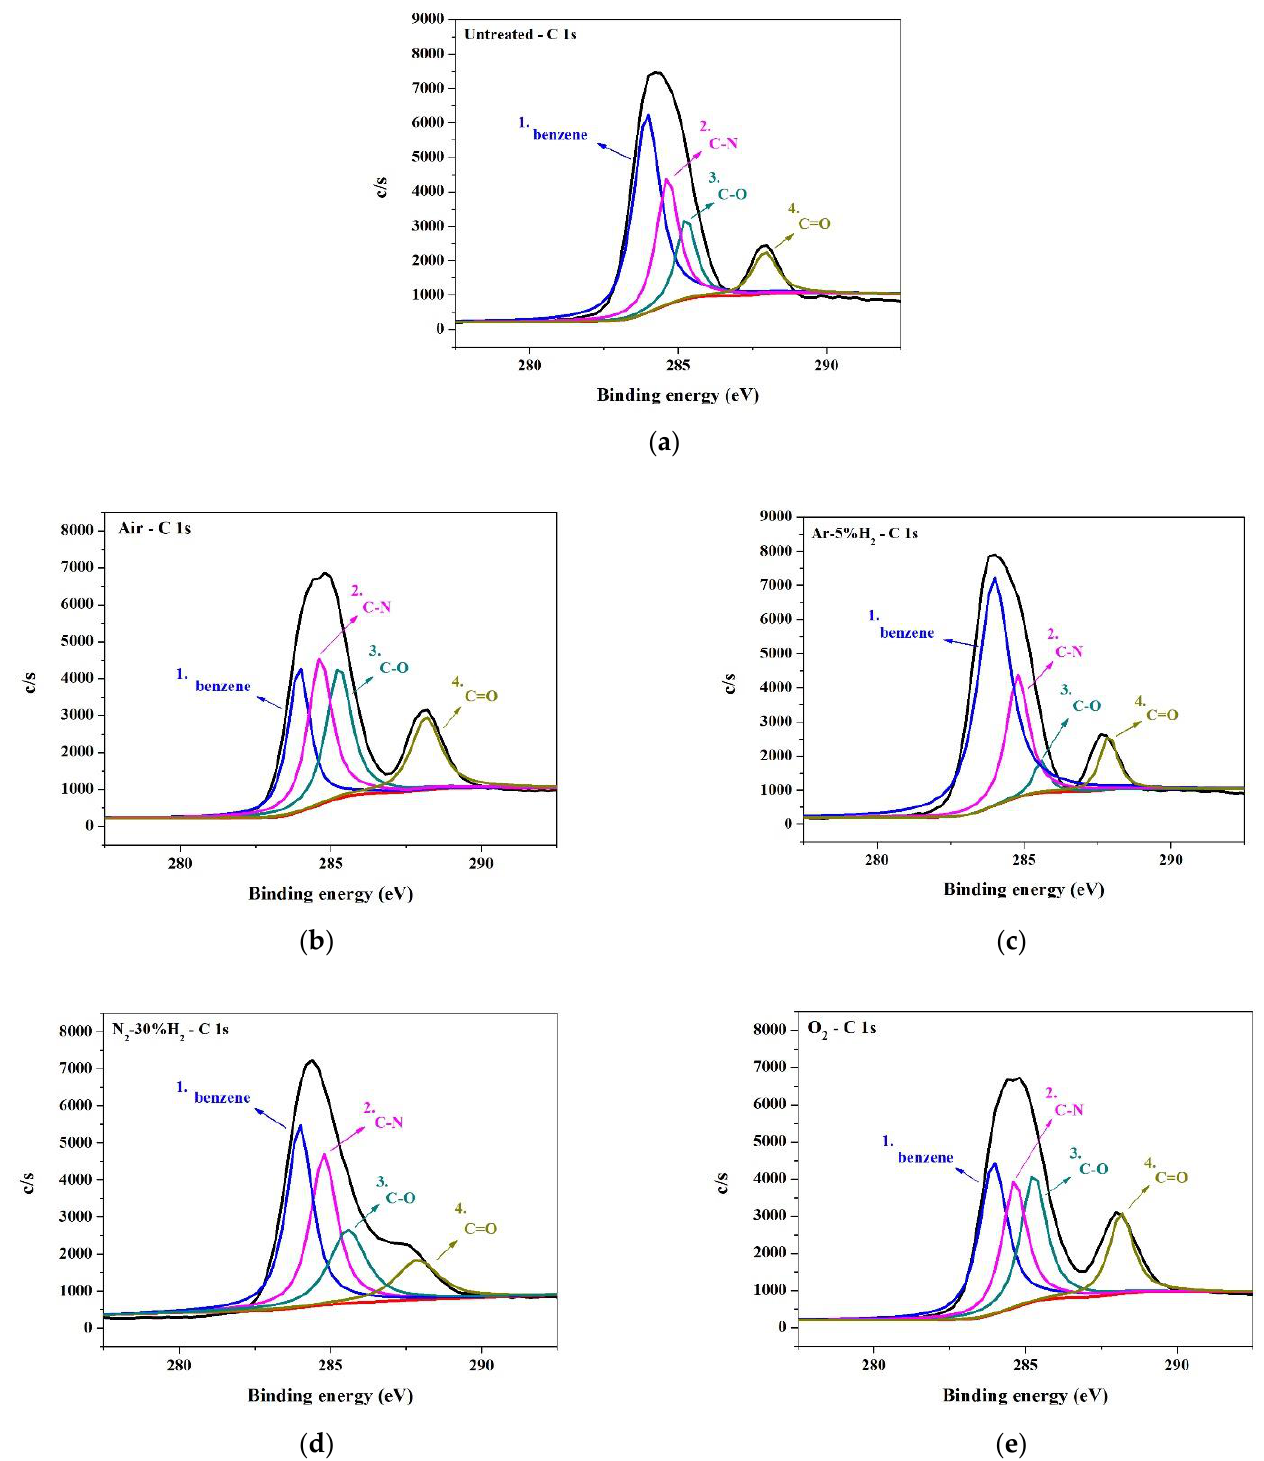
Figure 12. XPS C1s spectra of PI substrate surface: ( a ) untreated, ( b ) air, ( c ) Ar-5%H 2 , ( d ) N 2 -30%H 2 , and ( e ) O 2 .